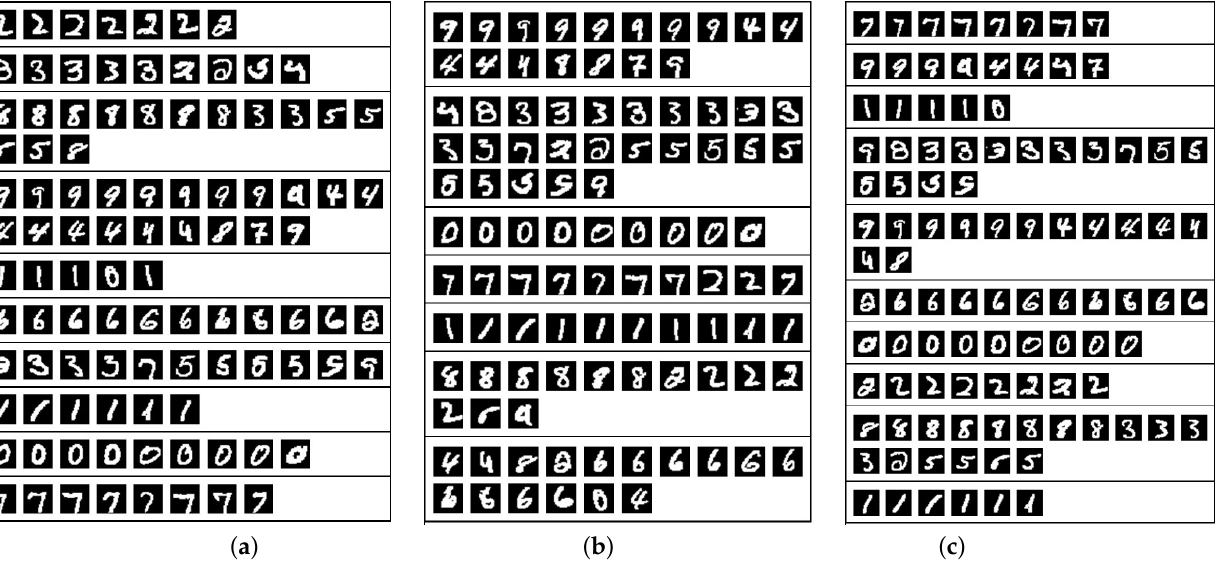
Figure 5. The results of the examples of Figure 2 clustered by KPKM ( a ), KFCM ( b ), and KKM ( c ). Table 5. Comparisons of KPKM with KFCM and KKM on the MNIST dataset in terms of NMI, ARI, and